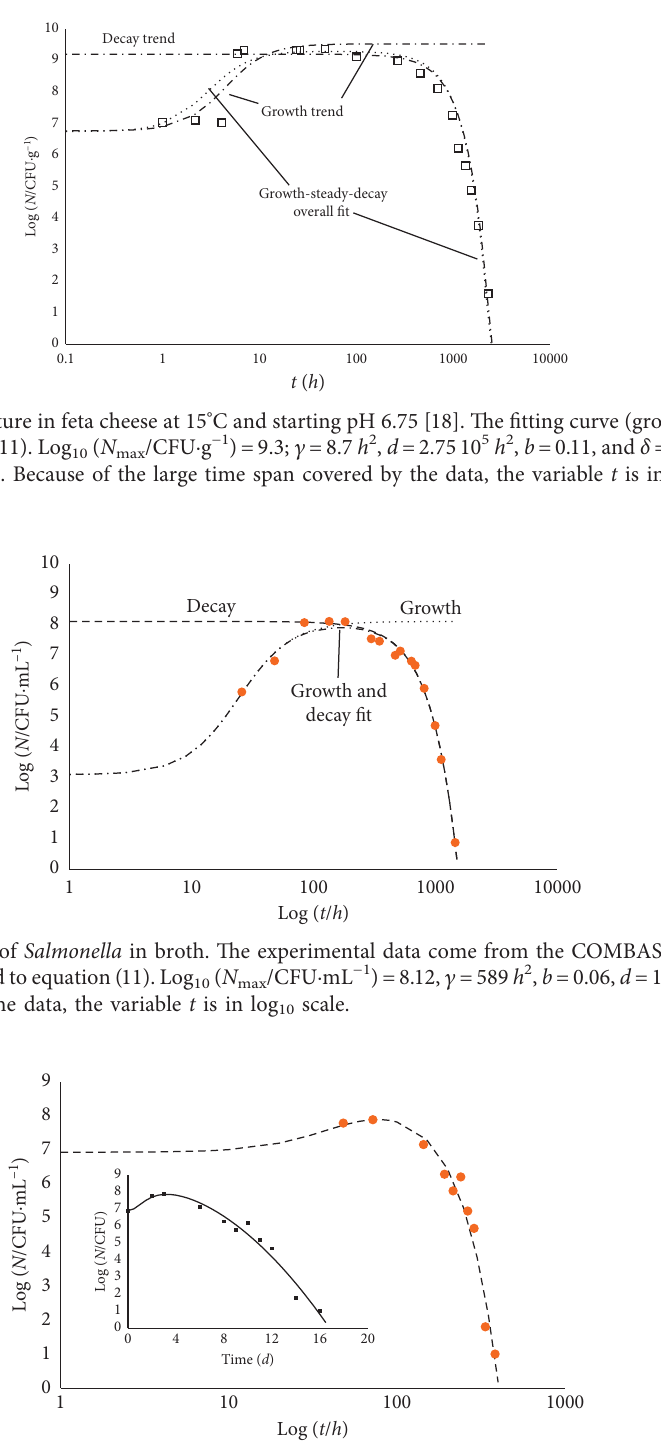
Figure 9: Escherichia coli at pH 4.5 in the presence of oregano oil. Plate count data after Skandamis and Nychas [13]. For the sake of comparison with the previous figures, the variable t is in log 10 scale. The insert reports the same data in the time units used in